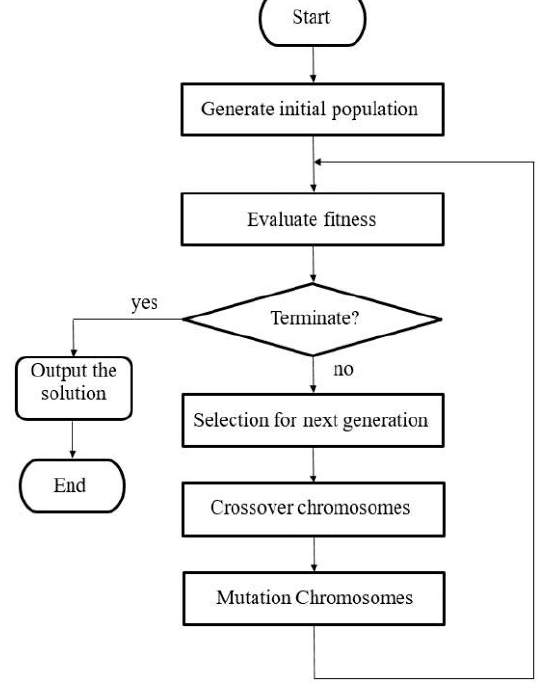
Figure 2. The flowchart of RCGA.